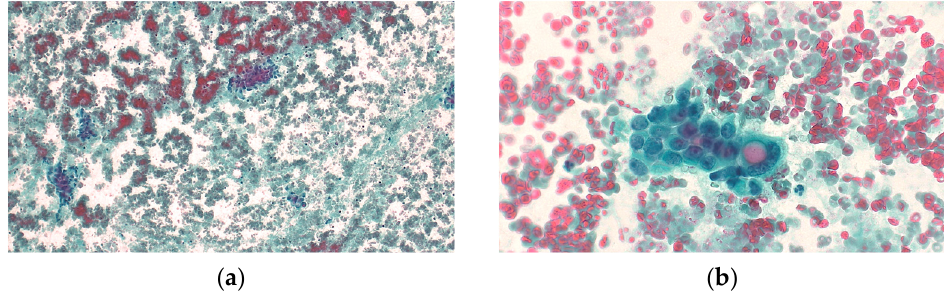
Figure 8. Example of scanty tumour tissue fragments in a heavily blood-stained smear. DQ ×100 ( a ), which could be overlooked but are focally diagnostic of malignancy ( b ). PAP ×400.